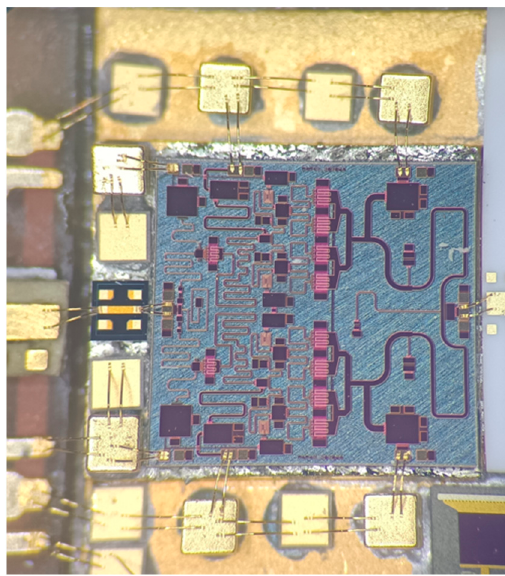
Figure 12. The partially enlarged picture of the proposed 30 W PA MMIC in the C-band module.